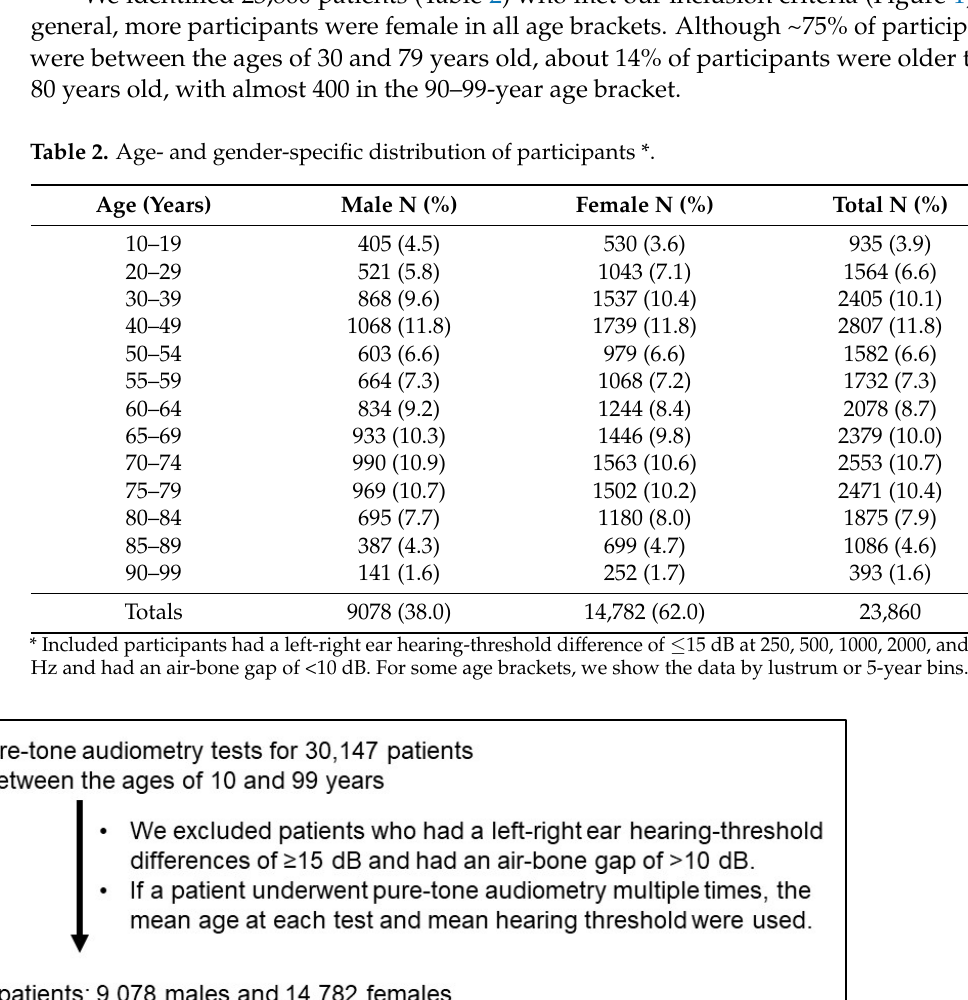
Table 2. Age- and gender-specific distribution of participants *.